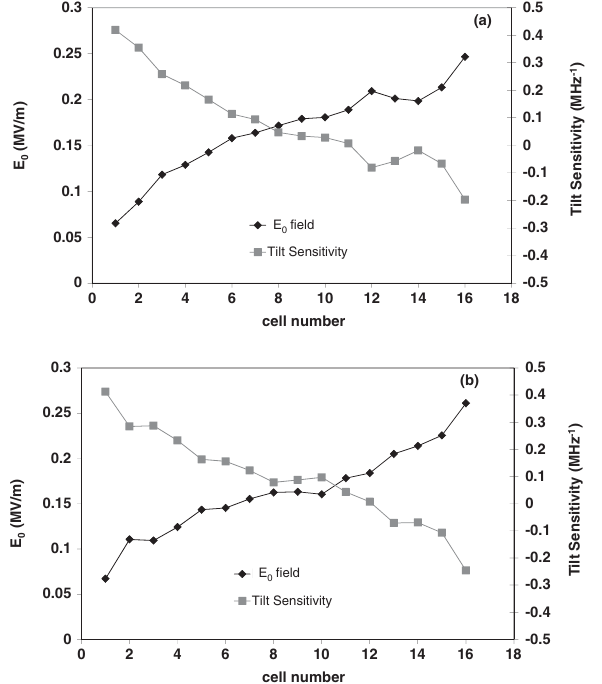
FIG. 29. (a) Gap PC - DT ¼ 25 mm is too large for 5 PCs configuration. (b) Gap PC - DT ¼ 22 mm is too large for 7 PCs configuration.